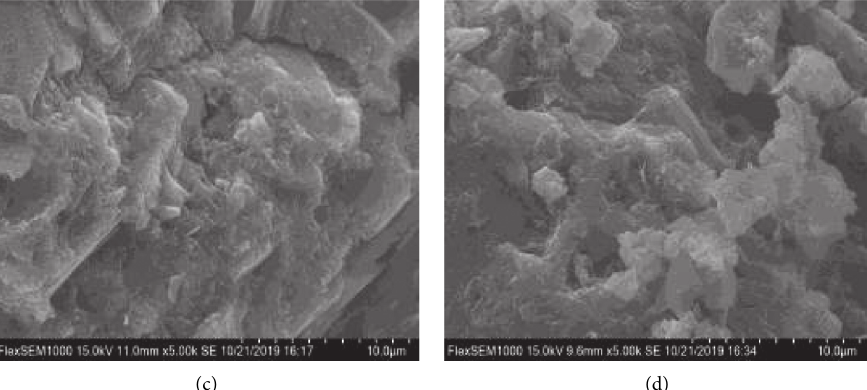
Figure 4: Representative SEM images of groups CA0 and CA2. (a) CA0 after curing for 3 days. (b) CA2 after curing for 3 days. (c) CA0 after curing for 28 days. (d) CA2 after curing for 28